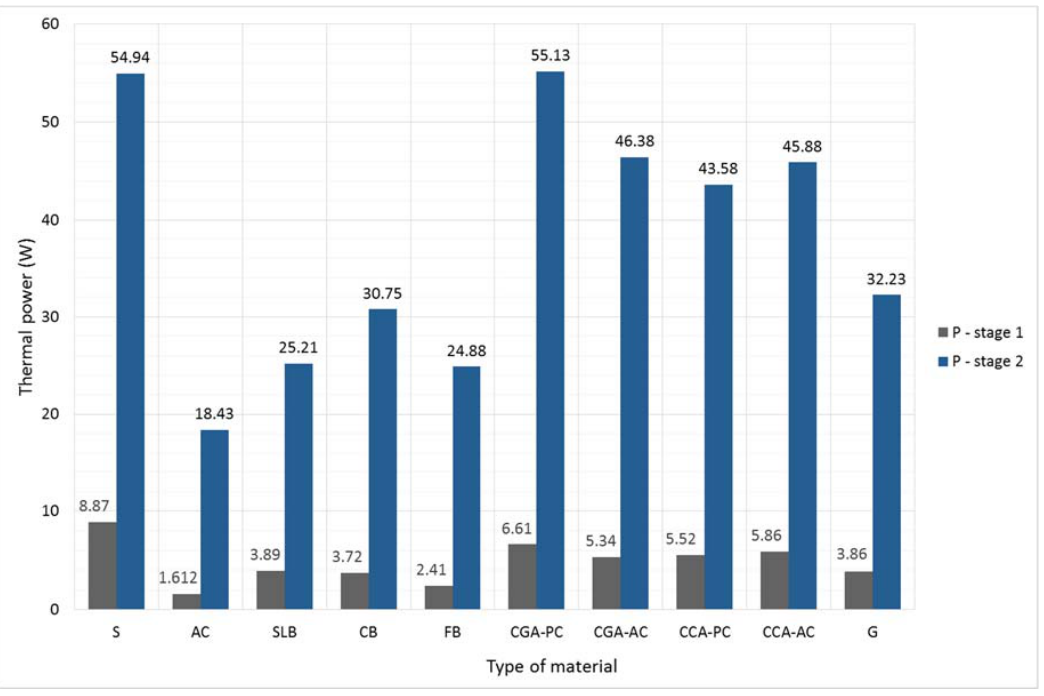
Figure 6. Comparison of the materials’ thermal power between the results obtained in the course of the first and the second stages of the experiment.